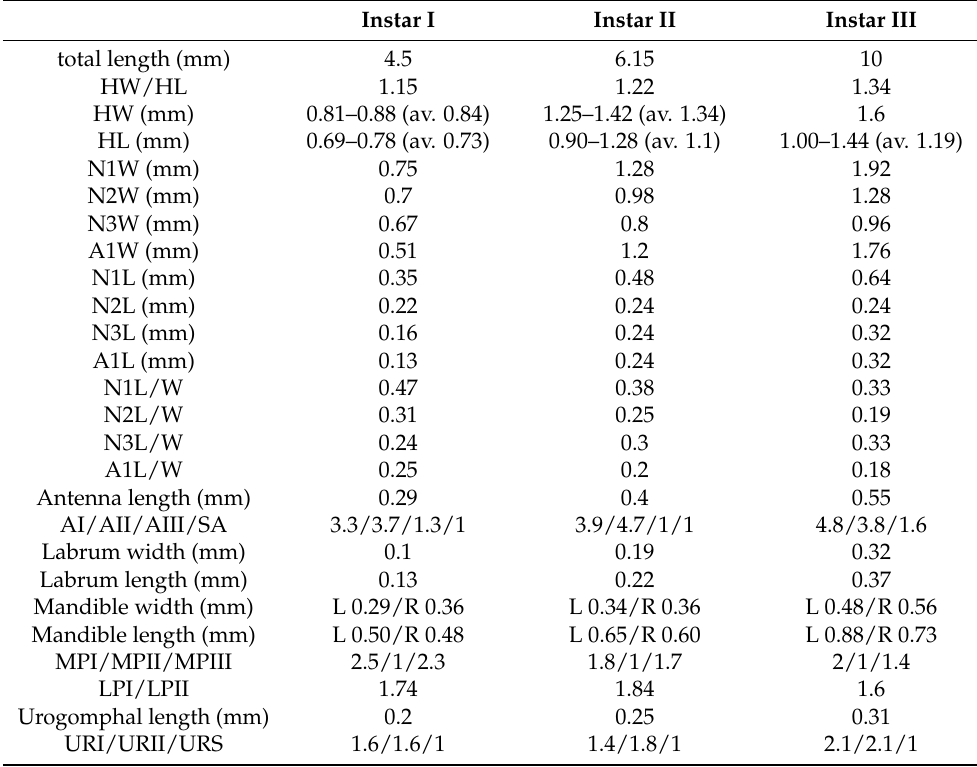
Table 1. Measurements and ratios of three instars of Leiodes cinnamomea